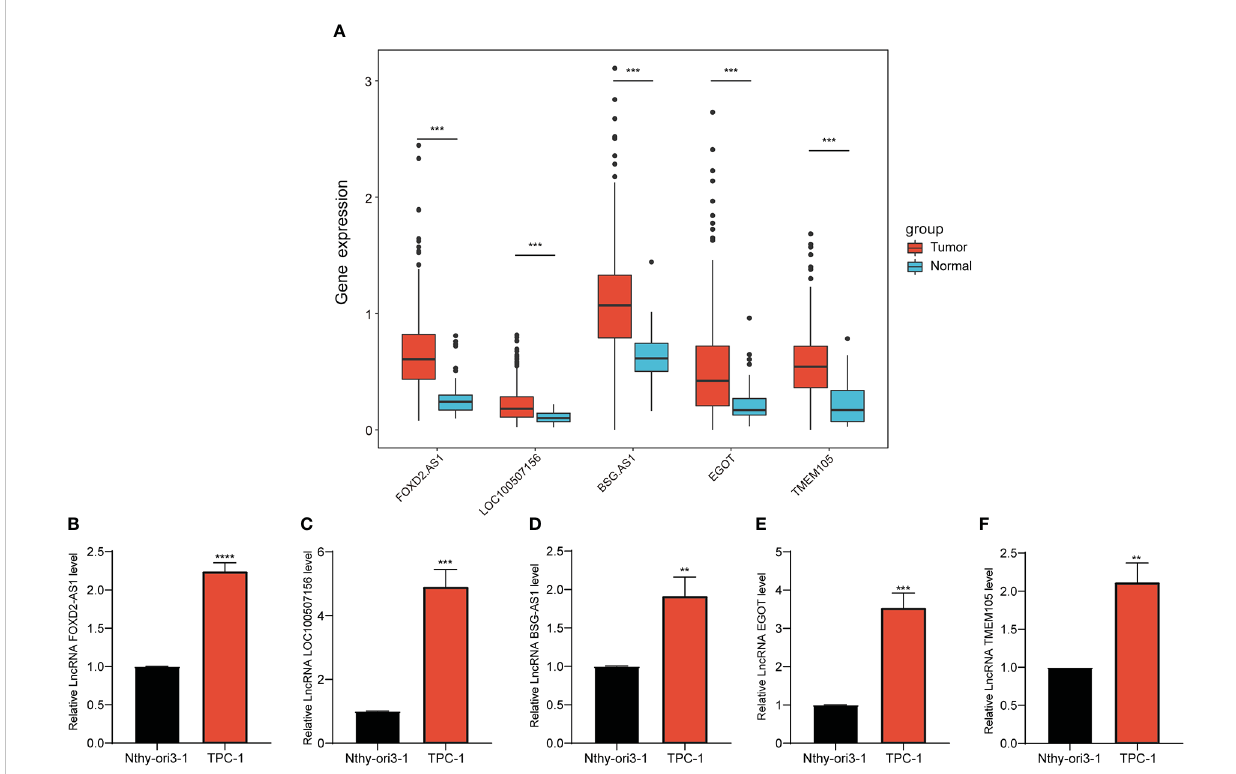
FIGURE 8 Expression of selected CCR-lncRNAs in cell lines. (A) Differential expression of fi ve CCR-lncRNAs between normal tissues and tumor tissues of PTC of TCGA. (B – F) Relative expression of fi ve CCR-lncRNAs in a PTC cell line and normal human thyroid cell line. CCR-lncRNAs, cell cycle – related long non-coding RNAs; PTC, papillary thyroid carcinoma (* P < 0.05, ** P < 0.01, *** P <